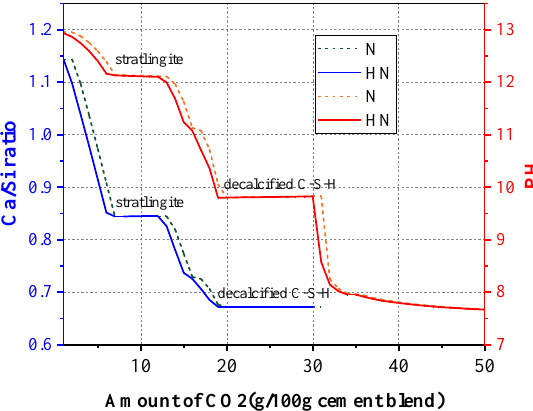
Figure 12. Changes of Ca/Si ratio and pH in contact with CO 2 .